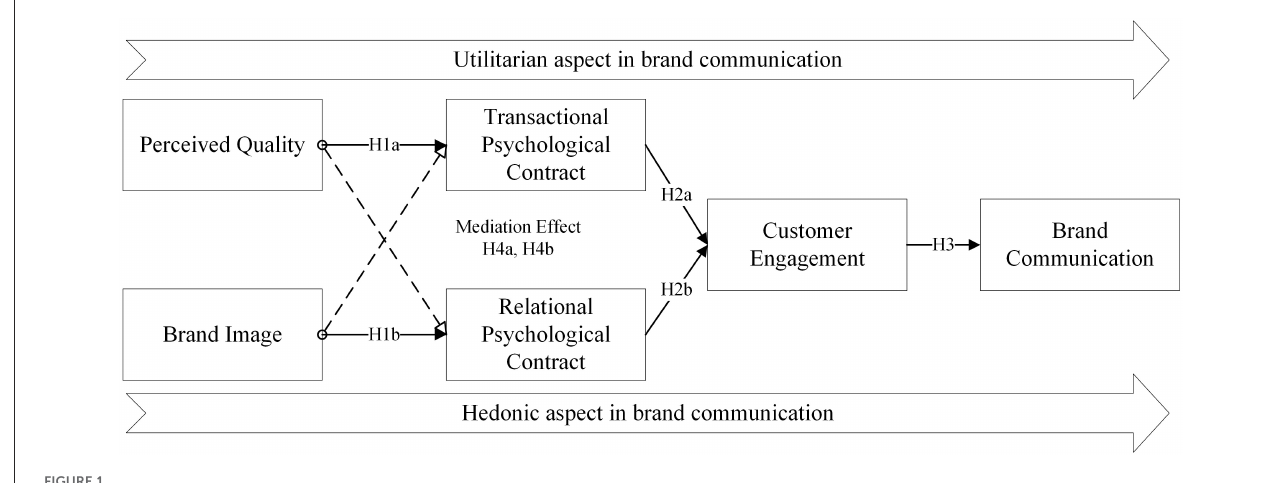
FIGURE1 Research model of hybrid communication in utilitarian and hedonic